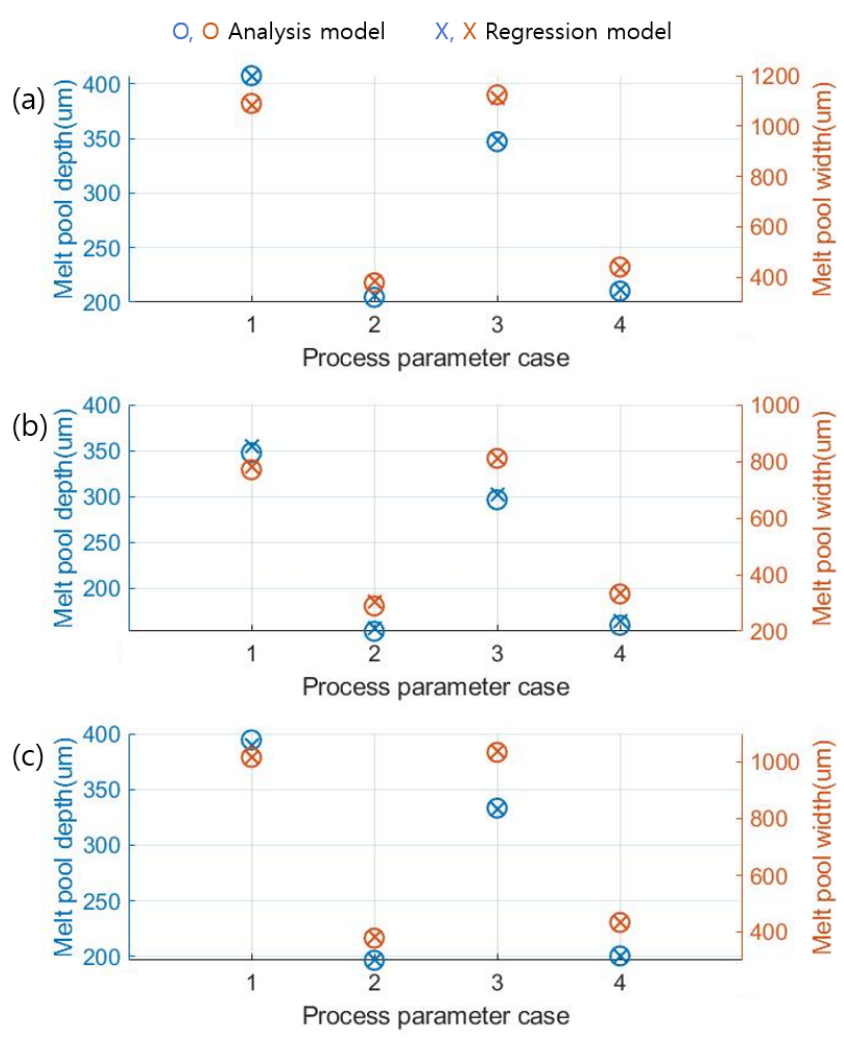
Figure 9. Regression model validation results (melt pool size): ( a ) analysis parameter case 1; ( b ) analysis parameter case 2; ( c ) analysis parameter case 3. Table 6. Relative error in melt pool size between analysis model and regression model.